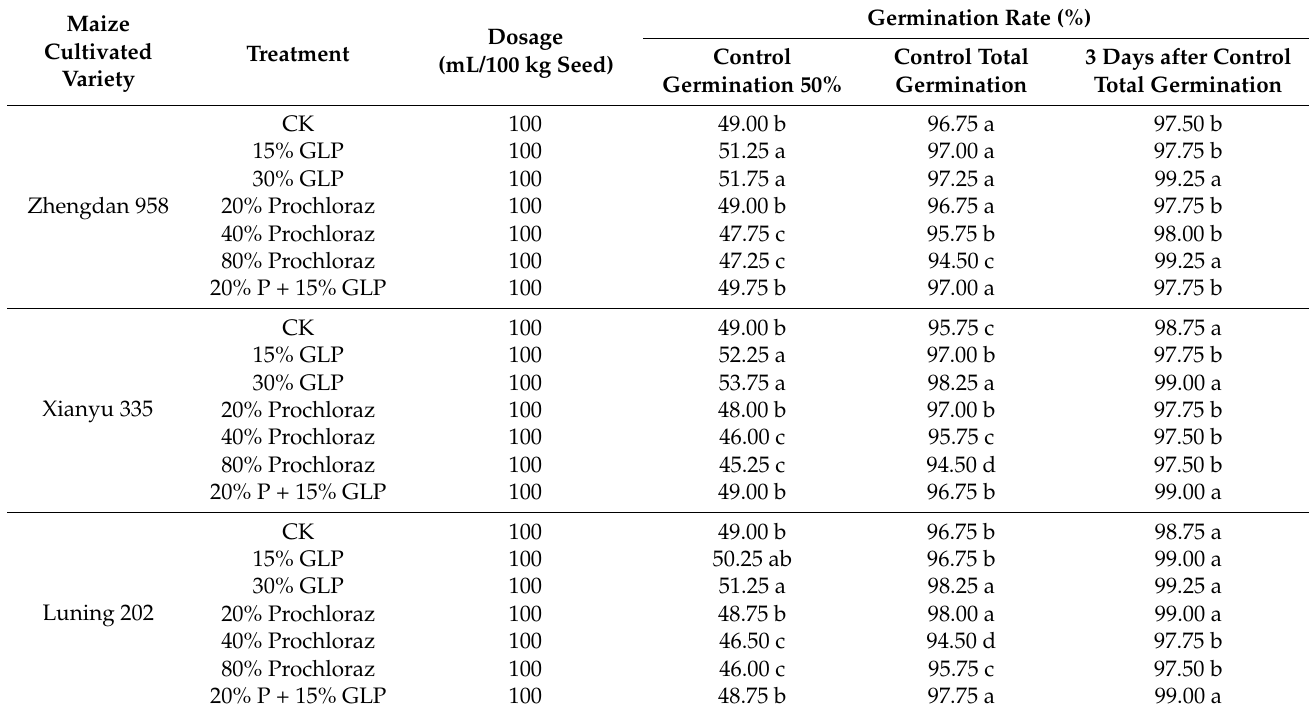
Table 6. Effects of seed dressing on maize